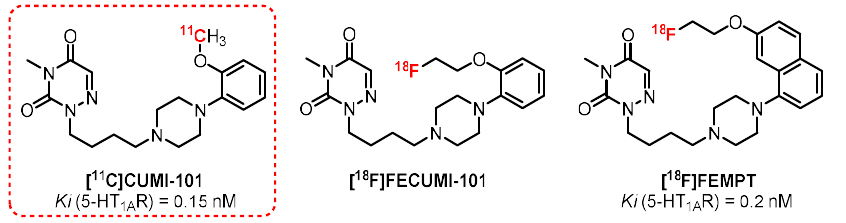
Figure 2. CUMI-101